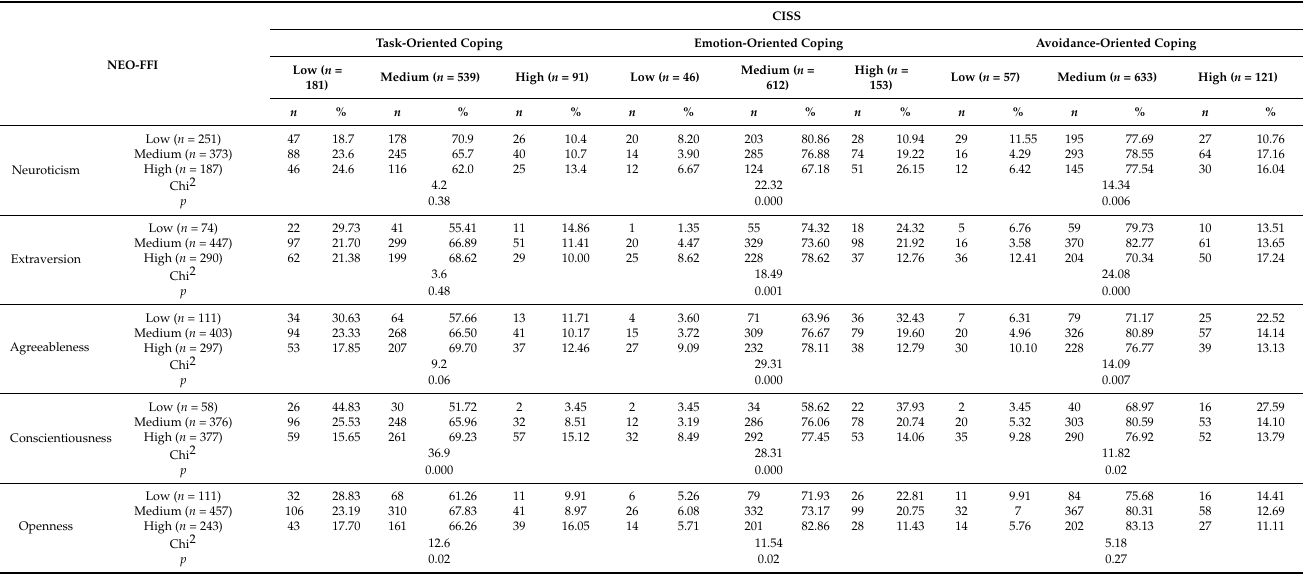
Table 5. The relationship between personality traits according to the NEO-FFI Questionnaire and styles of coping with stress according to the CISS Questionnaire (part